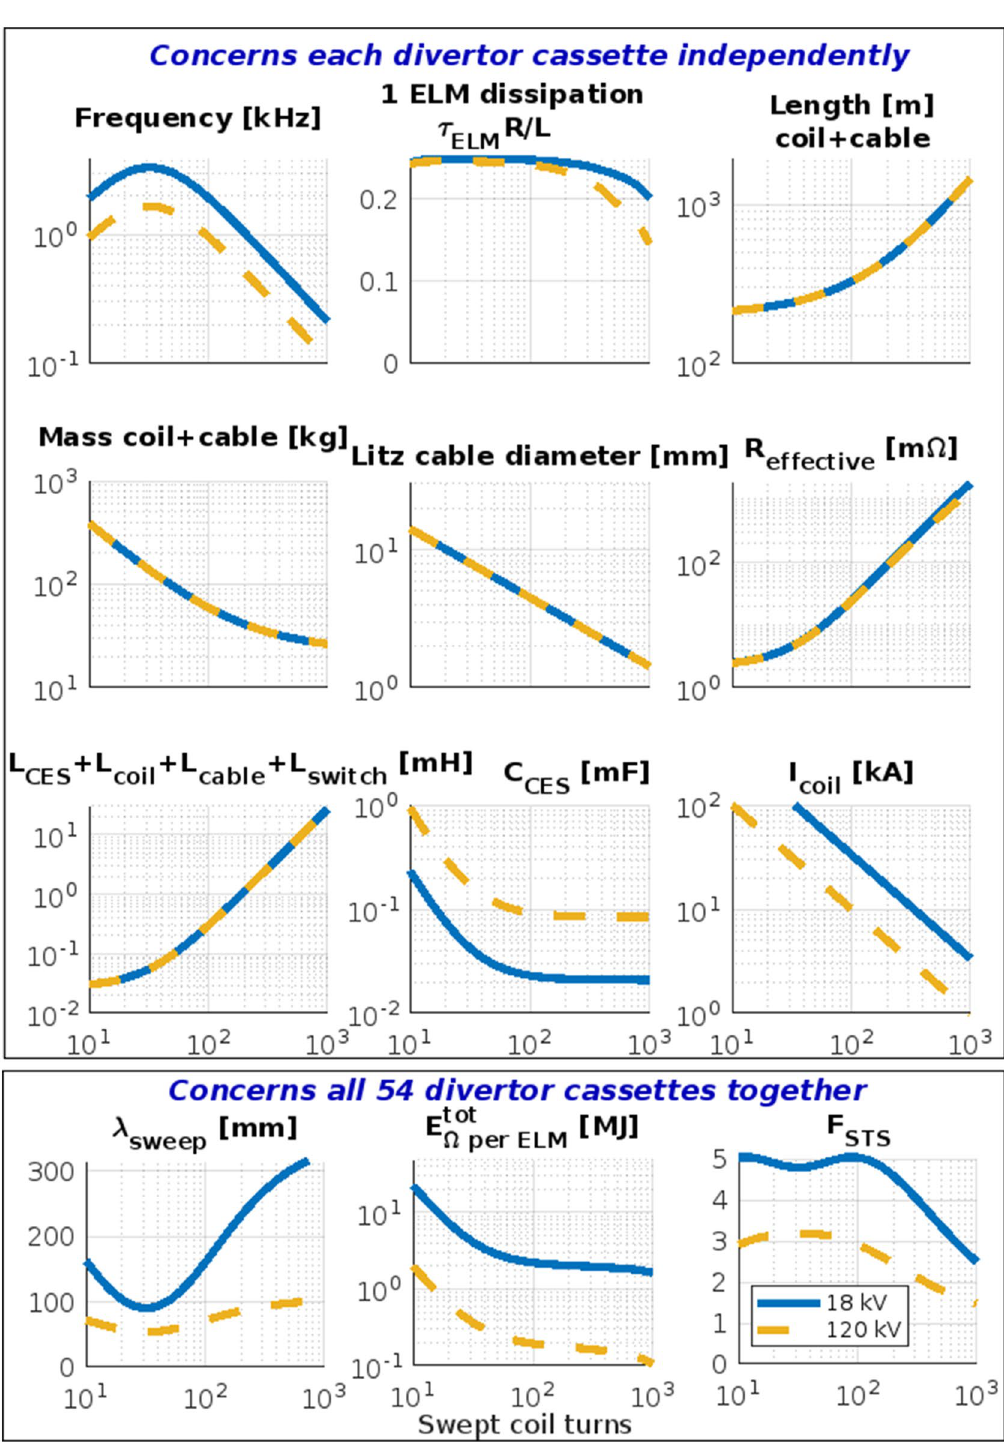
Figure 6. Scan over number of the swept coil turns. Assuming fixed geometry of the swept coil in DEMO divertor, 200 m distance to the capacitors, N = 54 coils, (cid:31) swp from Fig. 5, U 0 = 18 (blue) 1.6 nF. L cable = 28 µ H. τ